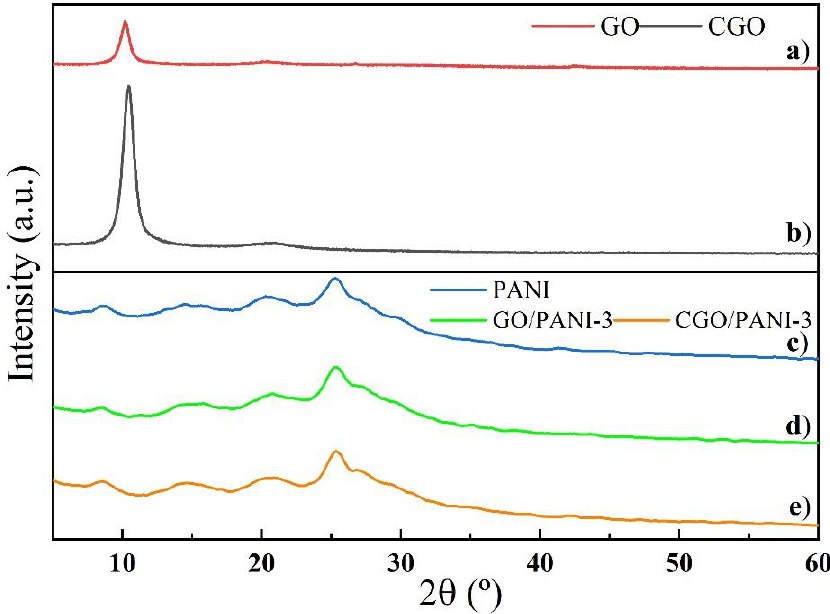
Figure 3. XRD spectra of ( a ) GO, (b) CGO, ( c ) PANI, ( d ) GO/PANI-3, (e) CGO/PANI-3.